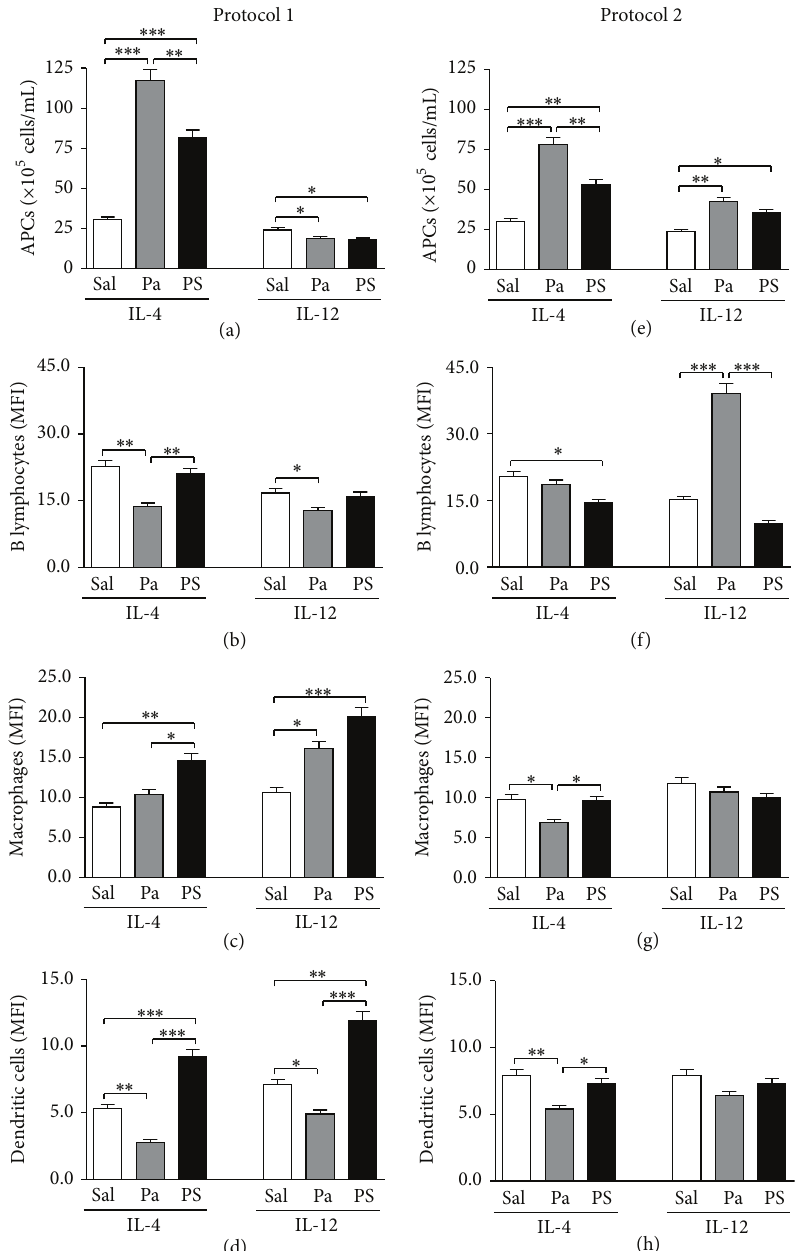
Figure 4: Cytokines synthesis by spleen antigen-presenting cells. Spleen cells from mice treated with saline (Sal), P. acnes (Pa), or PS were obtained 14 days after HEW implantation and stained with fluorochrome-conjugated monoclonal anti-mouse antibodies to determine the intracellular synthesis of IL-4 and IL-12 by B lymphocytes, macrophages, and dendritic cells. Percentages obtained by flow cytometric analysis were converted to absolute numbers of B lymphocytes, macrophages, and dendritic cells positive for each cytokine, which were added to obtain the total number of spleen APCs positive for such cytokine in Protocols 1 (a) and 2 (e). Production levels were also determined by mean fluorescence intensity (MFI) and individually analyzed in B lymphocytes ((b) and (f)), macrophages ((c) and (g)), and dendritic cells ((d) and (h)) for Protocols 1 and 2, respectively. ∗ 𝑃 < 0.05 ; ∗∗ 𝑃 < 0.01 ; ∗∗∗ 𝑃 < 0.0001